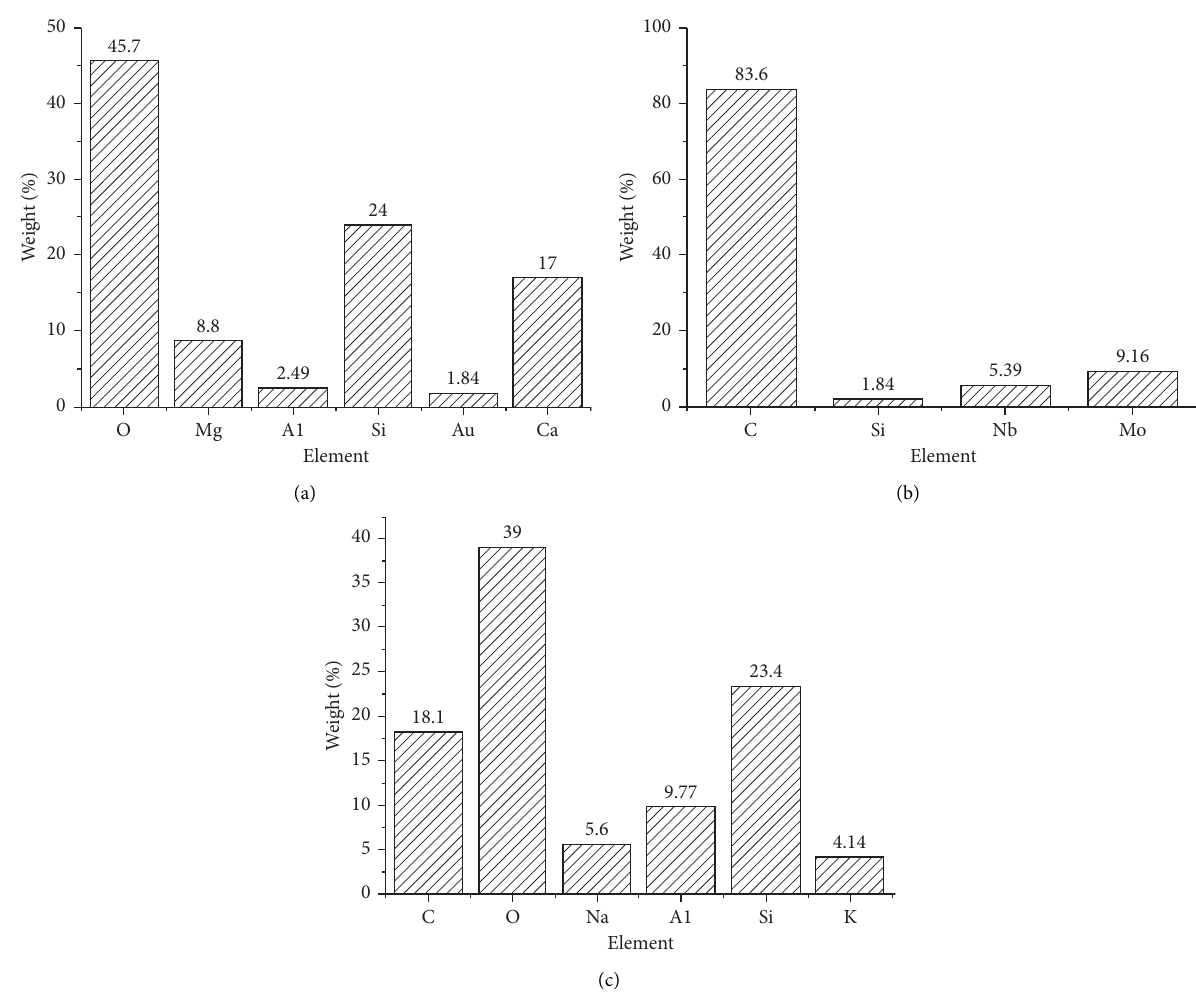
Figure 15: EDS results of SFP mixture. (a) Spot 1. (b) Spot 2. (c) Spot